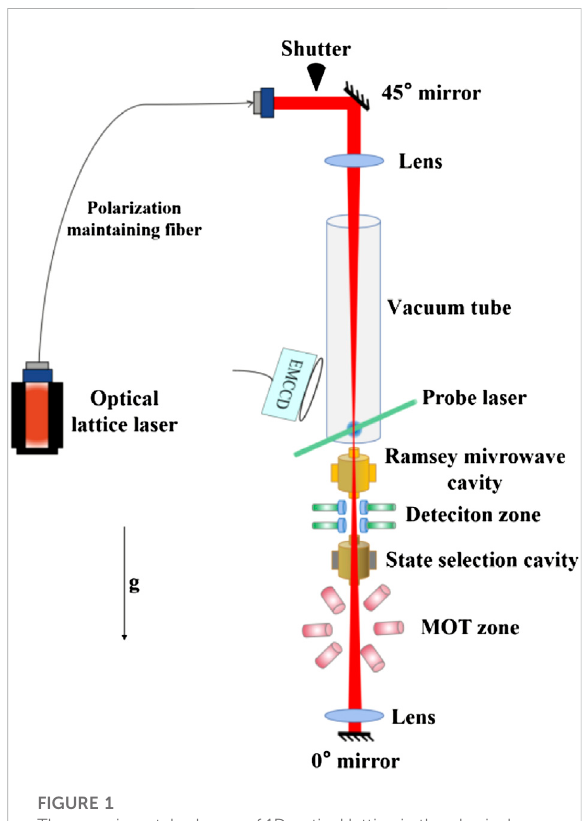
FIGURE 1 The experimental scheme of 1D optical lattice in the physical package of the beyond